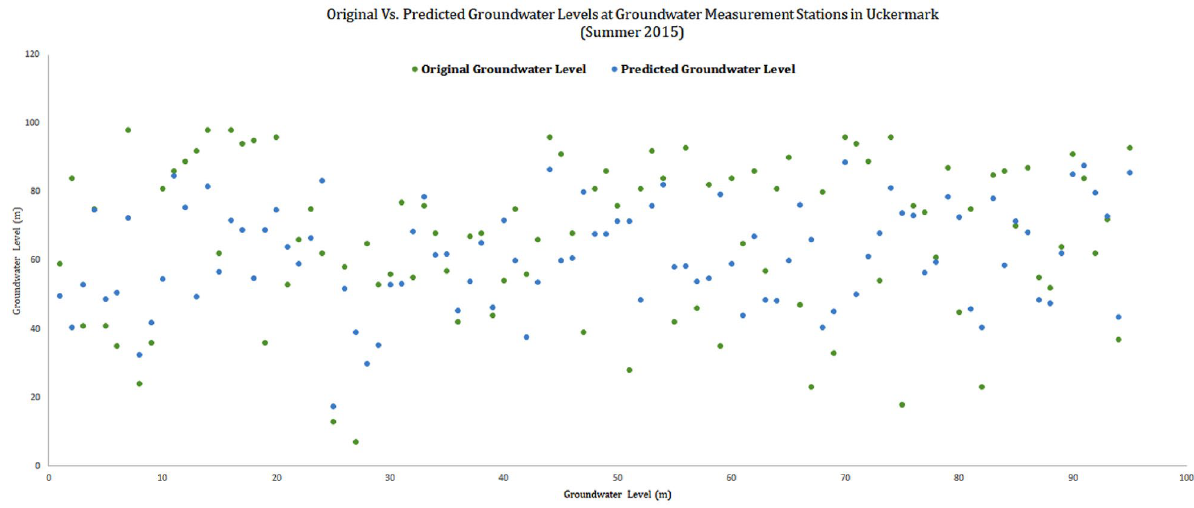
Figure 6. Original and predicted groundwater data of 95